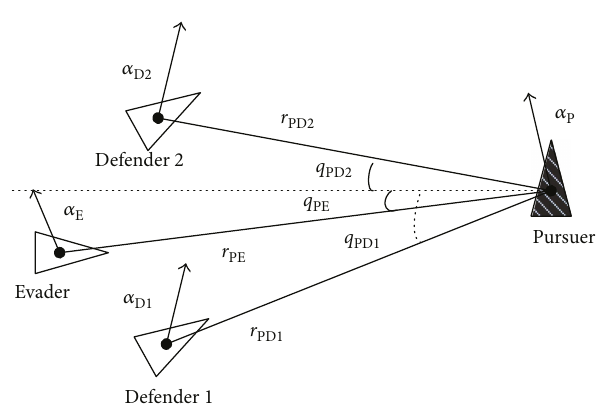
Figure 1: Schematic diagram of a four-aircraft